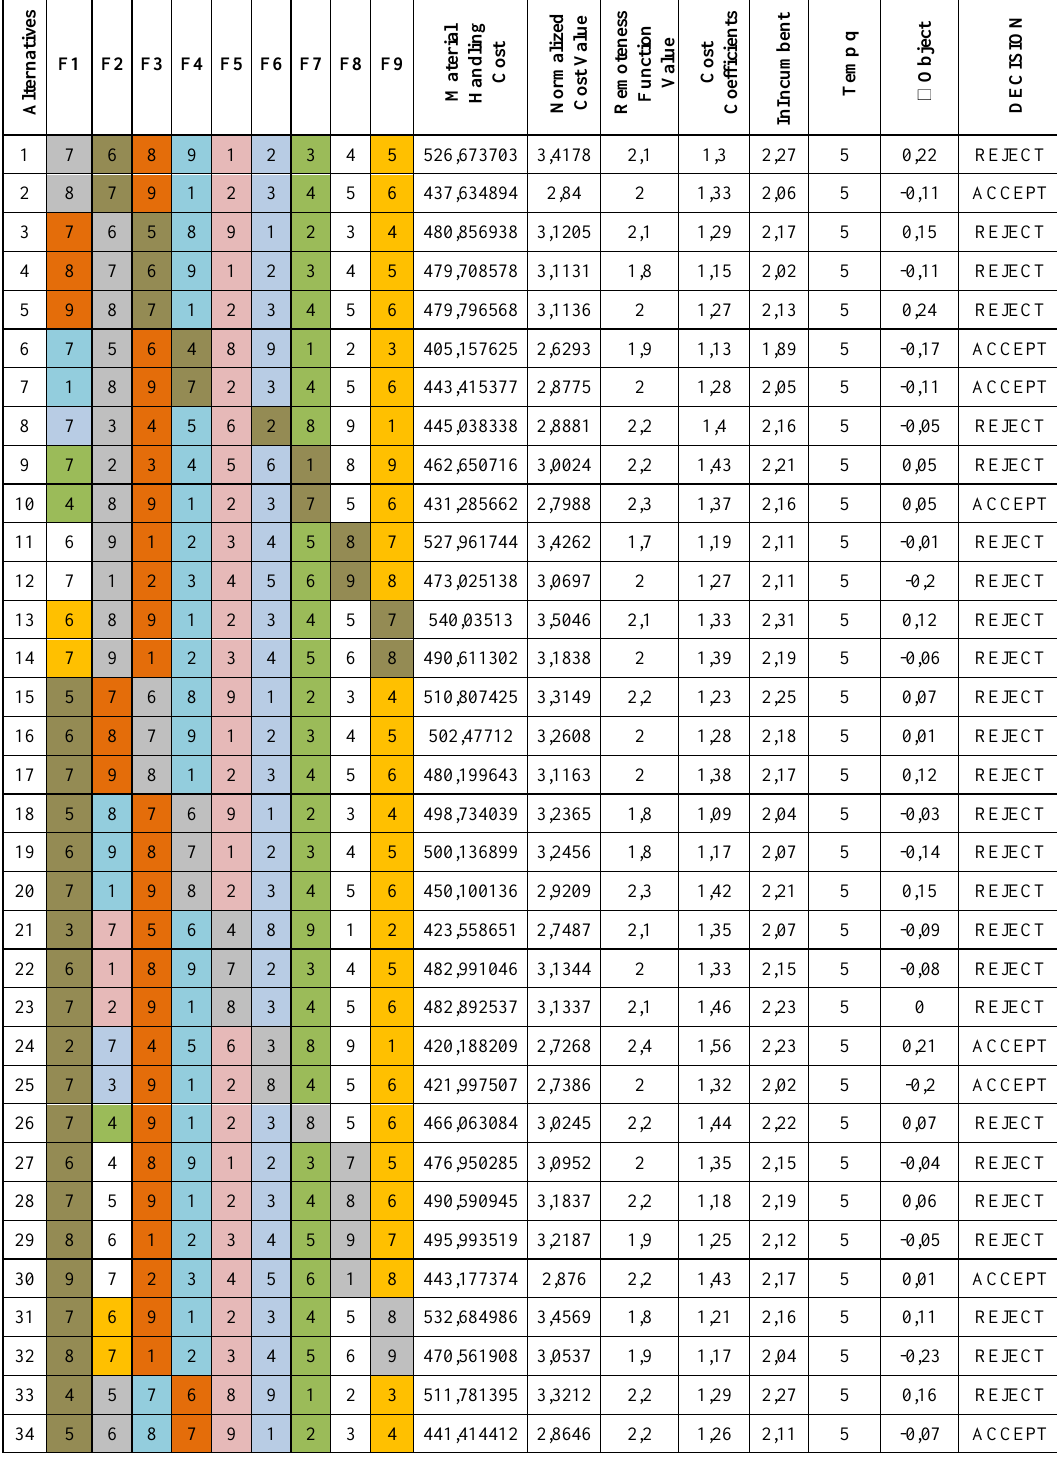
Table 9. Computational